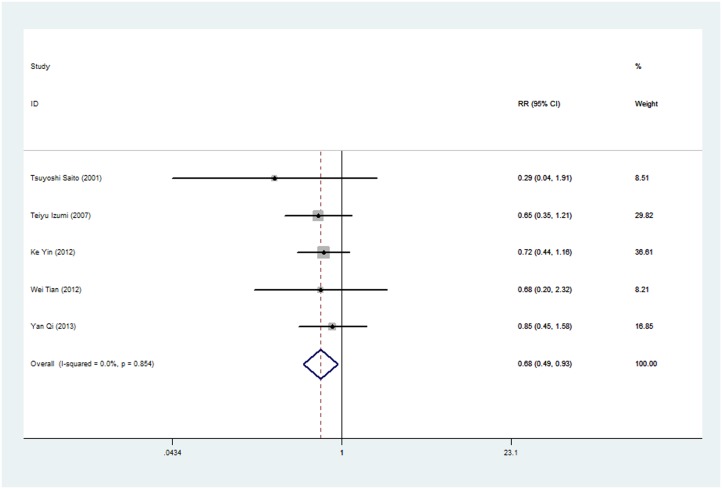
Risk ratio (RR) and 95% confidence intervals (CIs) in studies assessing the relationship between E-cadherin expression and male patients in sarcoma.(P = 0.017, RR = 0.678; 95%CI: 0.493–0.933).